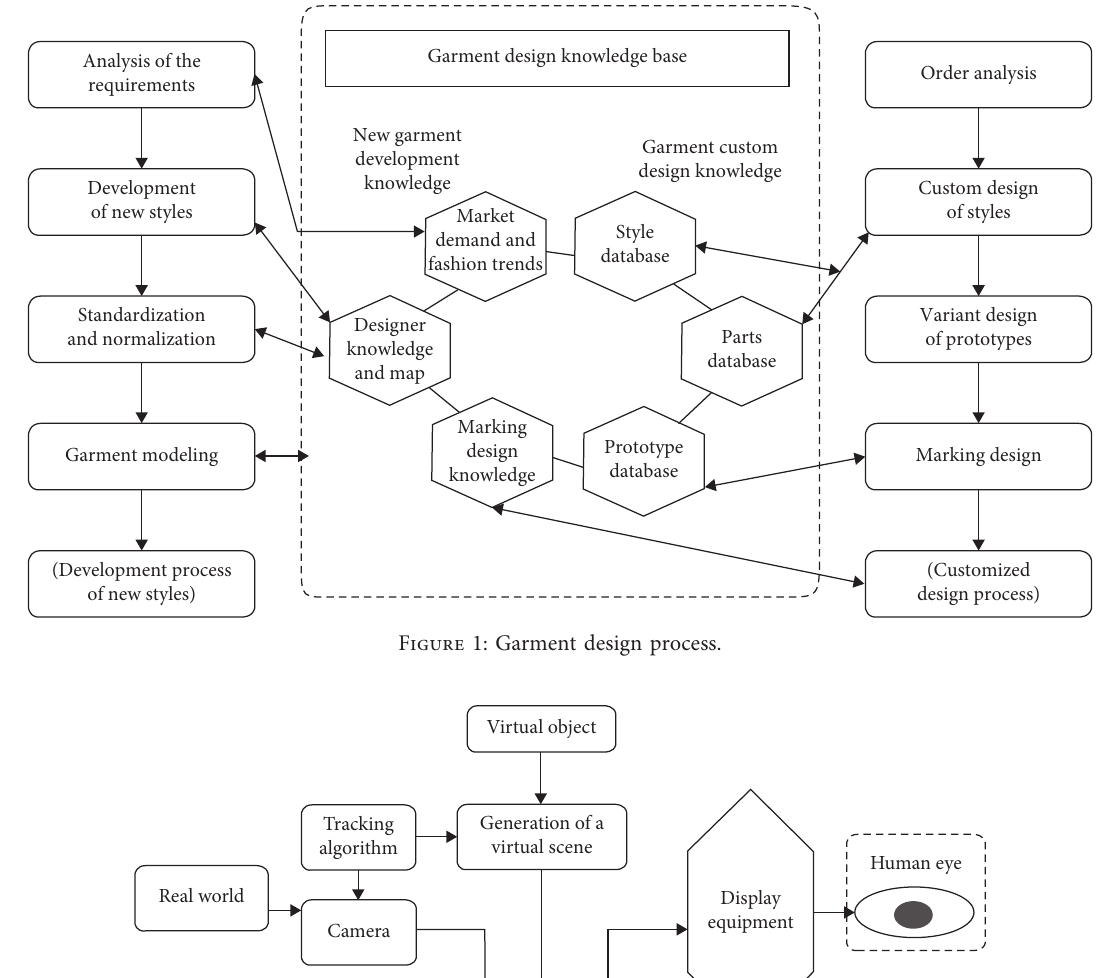
Figure 2: Diagram of the virtual reality model for surplus fabric removal and reuse without segmentation of cutting pieces.